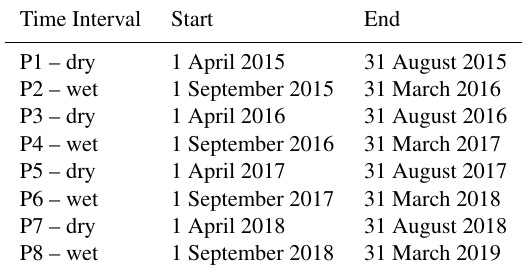
Table 1. Start and end times of the temporal intervals used for the partition of the